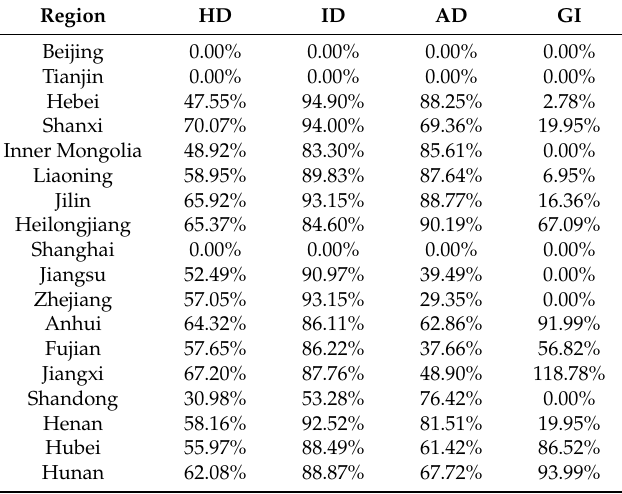
Table A2. The extent of output improvement of China in